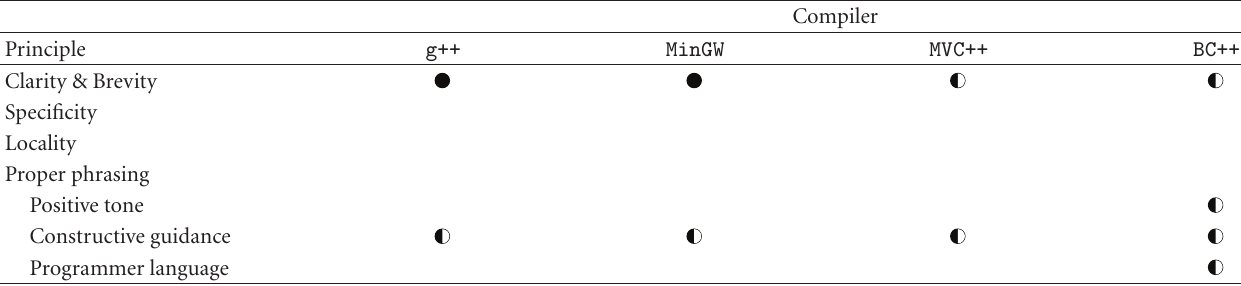
Table 6: Which principles are violated by which compilers for Error message